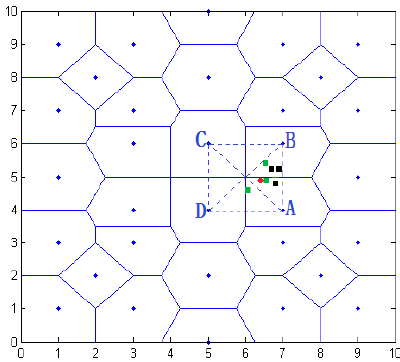
Figure 15. Region division positioning result. Table 3. The localization results with RSSI fluctuating 5%.